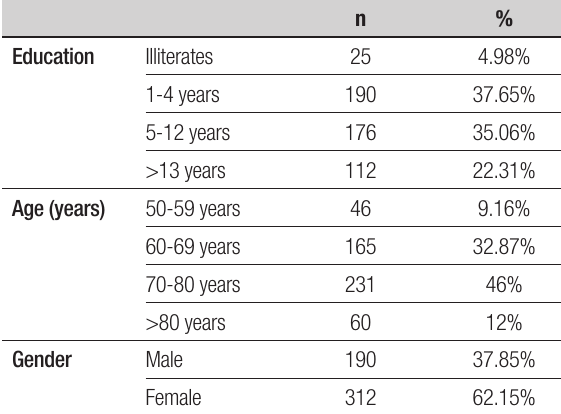
Table 1. Demographic data (n=502).